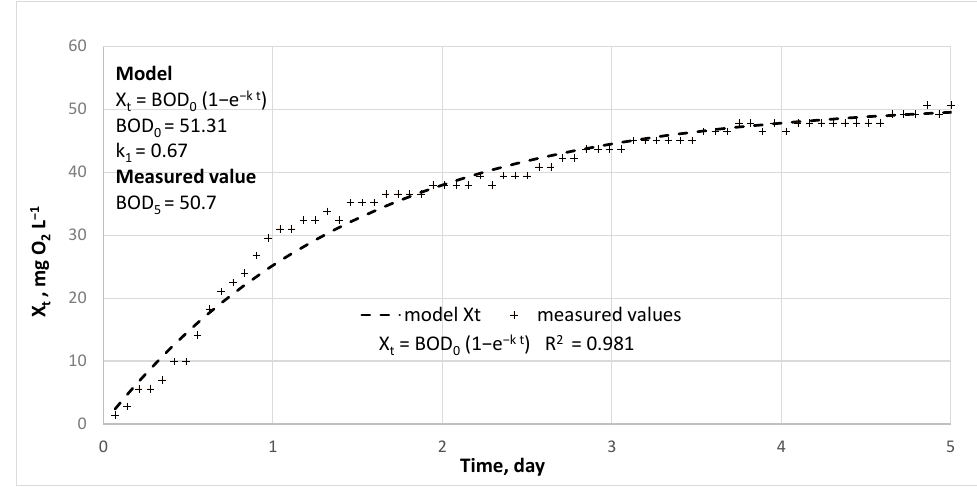
Figure 7. Value of biochemical oxygen consumption in rejected water, WWTP 2, sample 2.